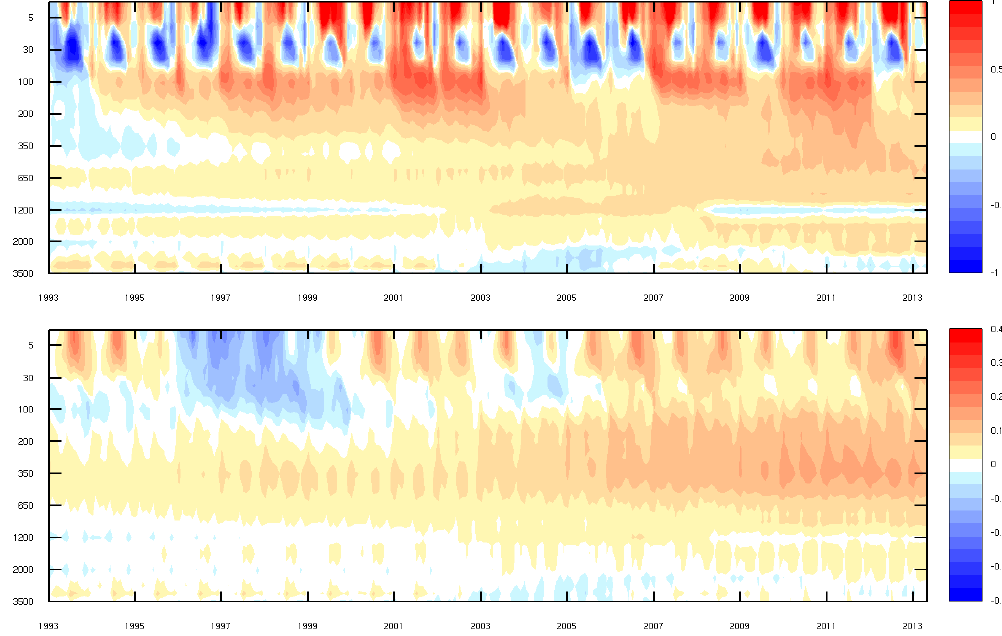
Figure 10. NM12-FREE basin mean temperature ( ◦ C, above) and salinity (psu, below) anomalies with respect to MedAtlas-1979.